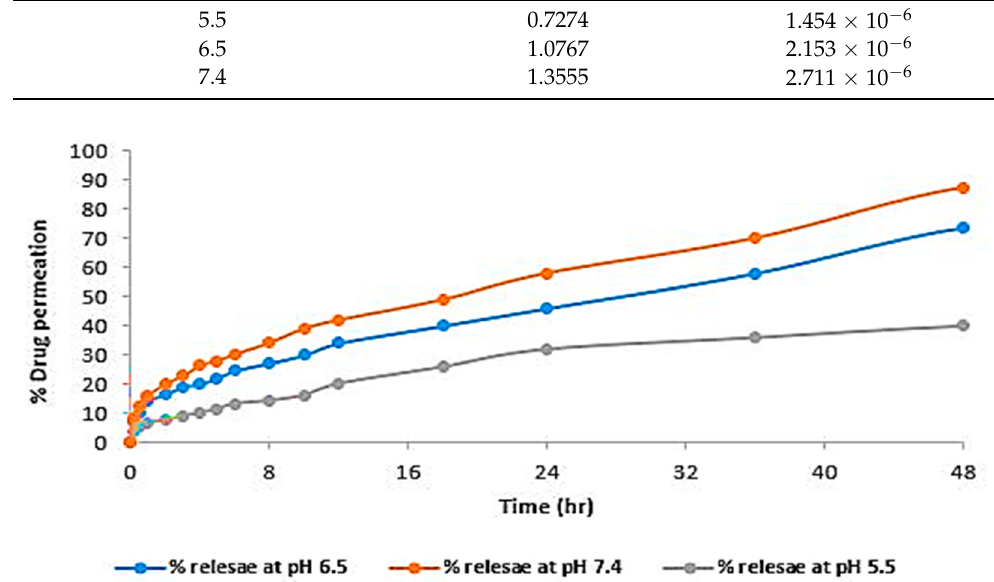
Figure 9. Drug permeation across synthetic membrane with time at different pH. Table 4. Permeability flux (Jss) and permeability coefficient (Kp) at different pH.